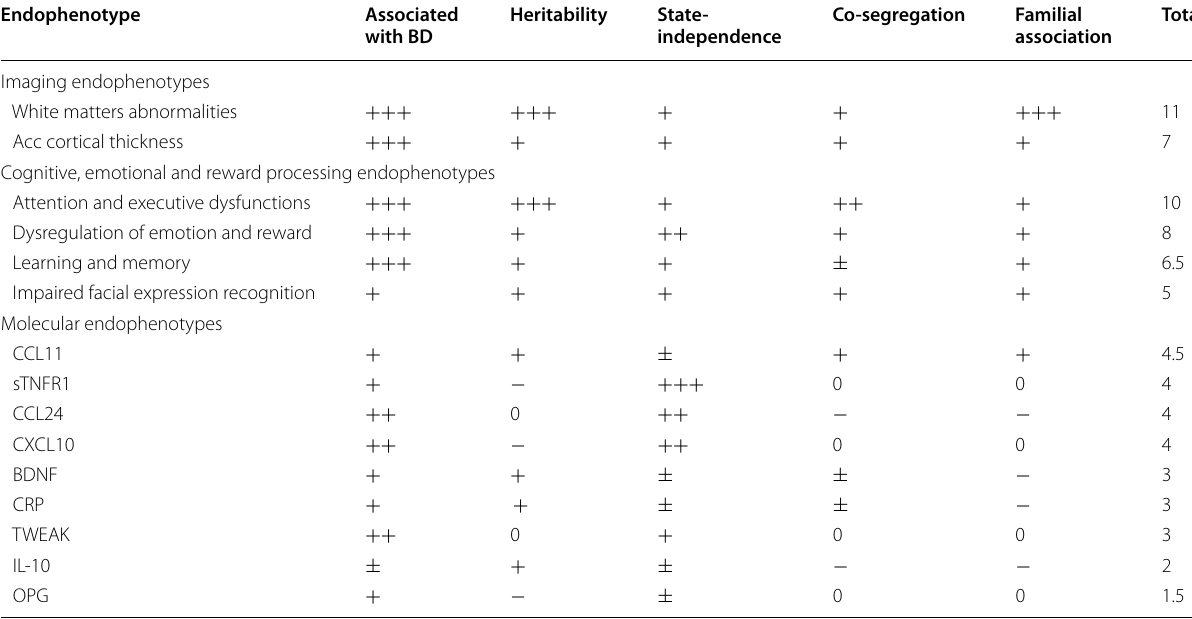
Table 1 Evaluation of putative endophenotypes for bipolar